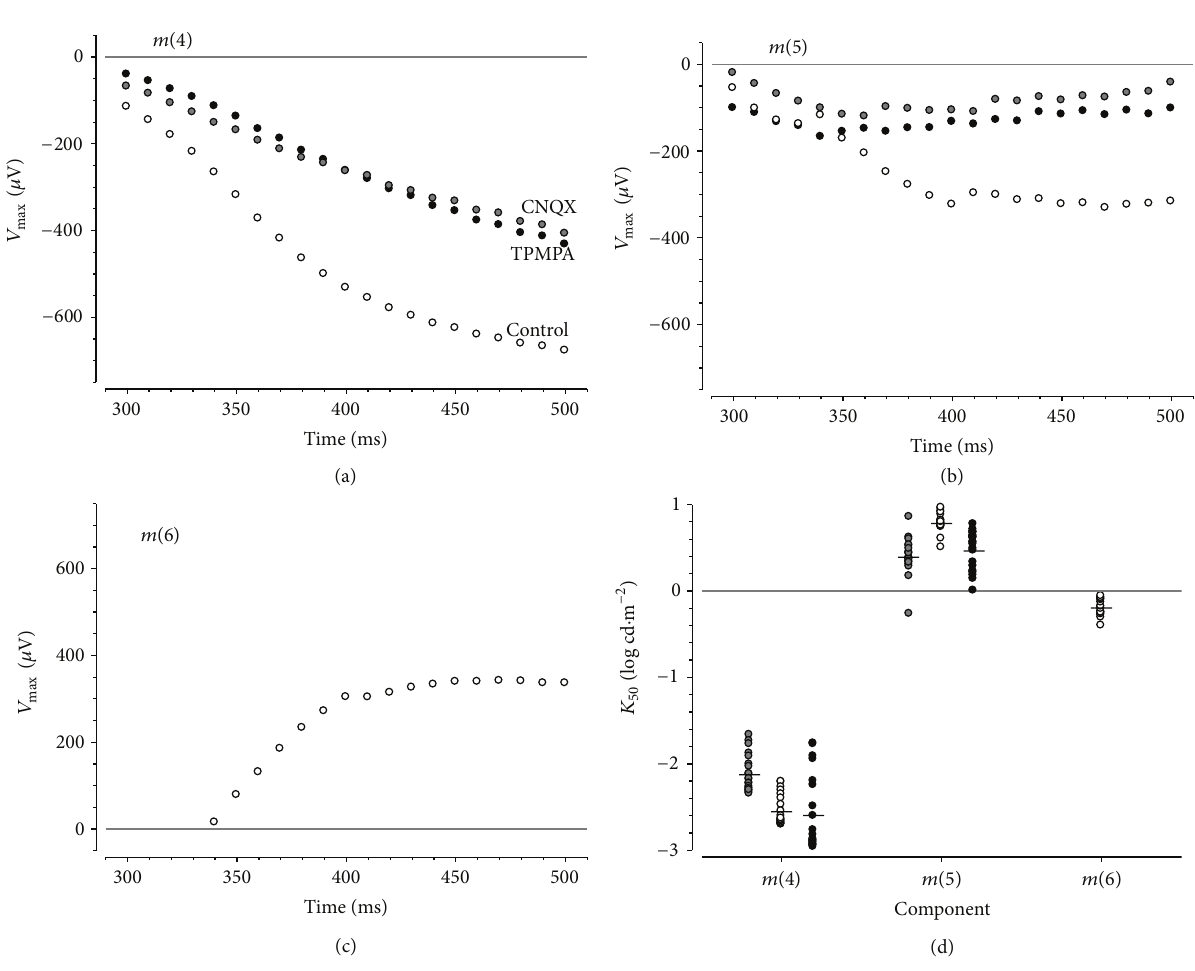
Figure 7: Effect of CNQX or TPMPA on rat PII after a light step. 𝑉 max is shown for m ( 4 ) (a), m ( 5 ) (b), and m ( 6 ) (c) mechanisms as a function of fixed time from light offset for controls (unfilled symbols), CNQX (grey symbols), and TPMPA (black symbols). (d) shows 𝐾 50 for the three mechanisms for controls (unfilled), CNQX (grey), or TPMPA treated (black). The average for each group is